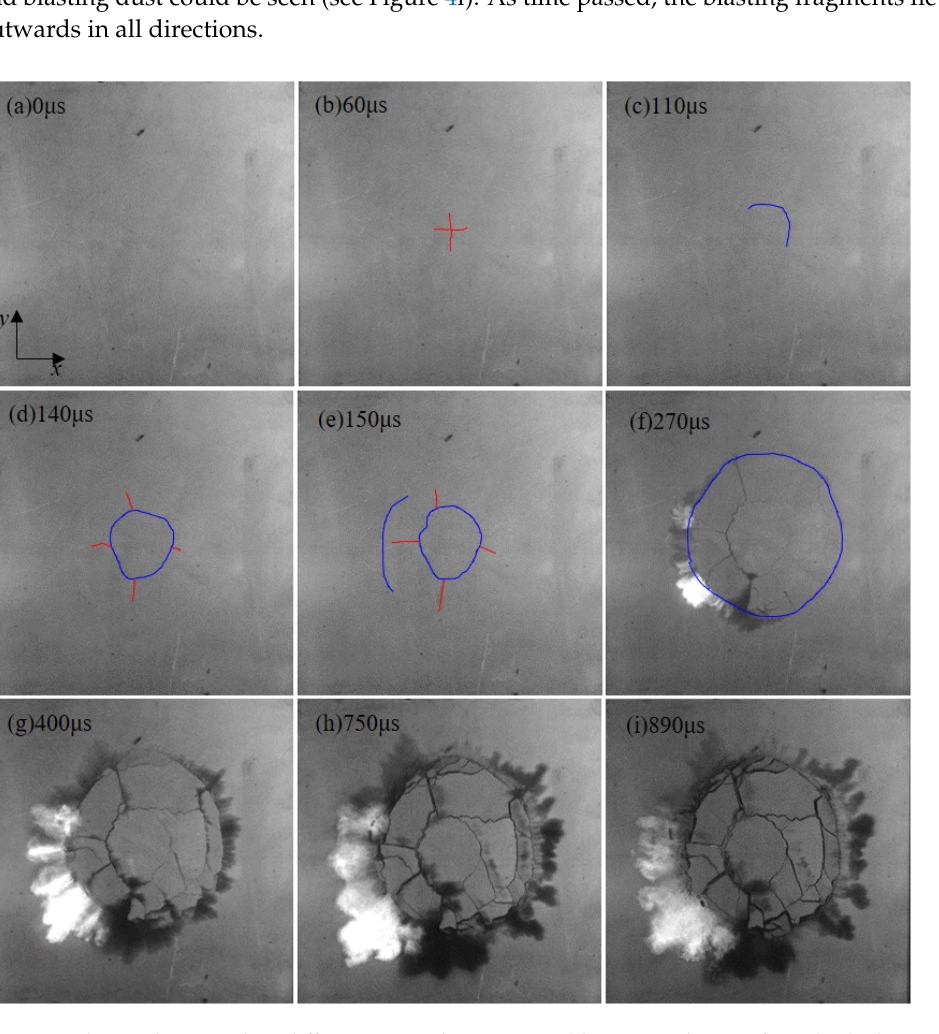
Figure 4. The crack network at different times during crater blasting under an of 0.1. ( a – i ) The crack network after 0, 60, 110, 140, 150, 270, 400, 750, and 890 μs of explosion, respectively.